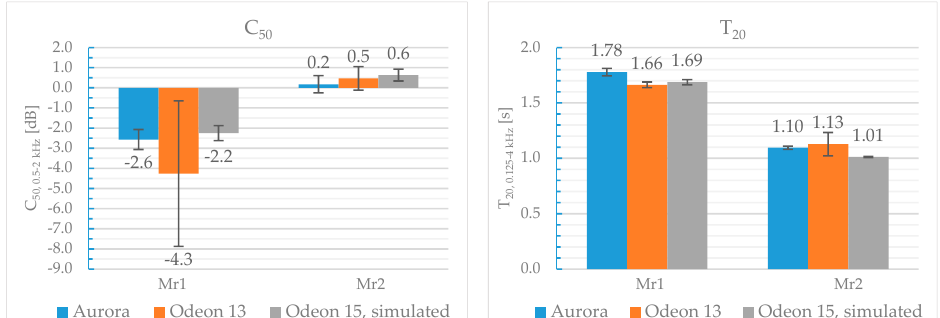
Figure 9. Spatial average value of Clarity C 50,0.5–2 kHz and Reverberation Time T 20,0.125–4 kHz in the Mr1 and Mr2 measured with ODEON 13 and Aurora plug-in, version 3.0, and simulated values with ODEON 15 are also shown for the untreated room. The error bars represent the standard deviation across different measurement positions.